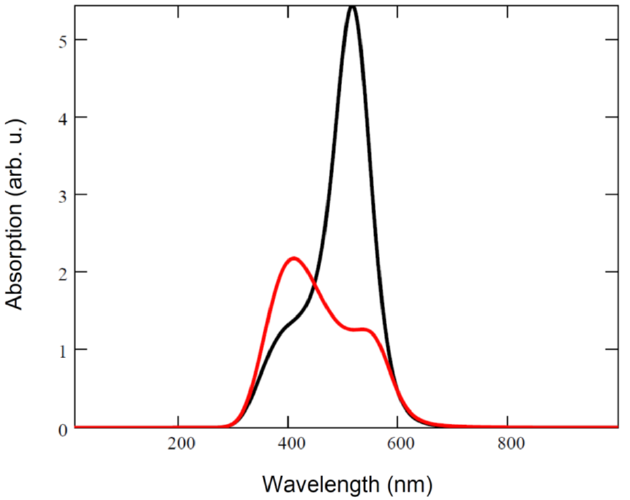
Figure 13. Transformation of the theoretical spectra of a model polymethine dye with different devi- ations from the nano-resonance condition θ = 1 / 2 (see Equations (4)–(6), in Equation (12) parameter θ = 1 / 2 ) [1,9]. The optical band that is near the nano-resonance band (black curve) corresponds to θ = 0.44, the optical band that is far beyond the nano-resonance band (red curve) corresponds to θ = 0.88. Both bands are computed from Equations (7)–(27), where the “dye + environment” system parameters are m = m e ( m e is the electron mass); n ref = 1.33; ω = 5 × 10 13 s − 1 ; J 1 = 5 eV; J 1 − J 2 = 0.5 eV; E = 1 eV; L black = 0.384 nm; L red = 2 L black ; γ black = 0.45 eV; γ red = 0.34 eV; and T = 298 K. A mathcad program file validating these results is available at http://dx.doi.org/10.17632/c4h9rm5xk6.1